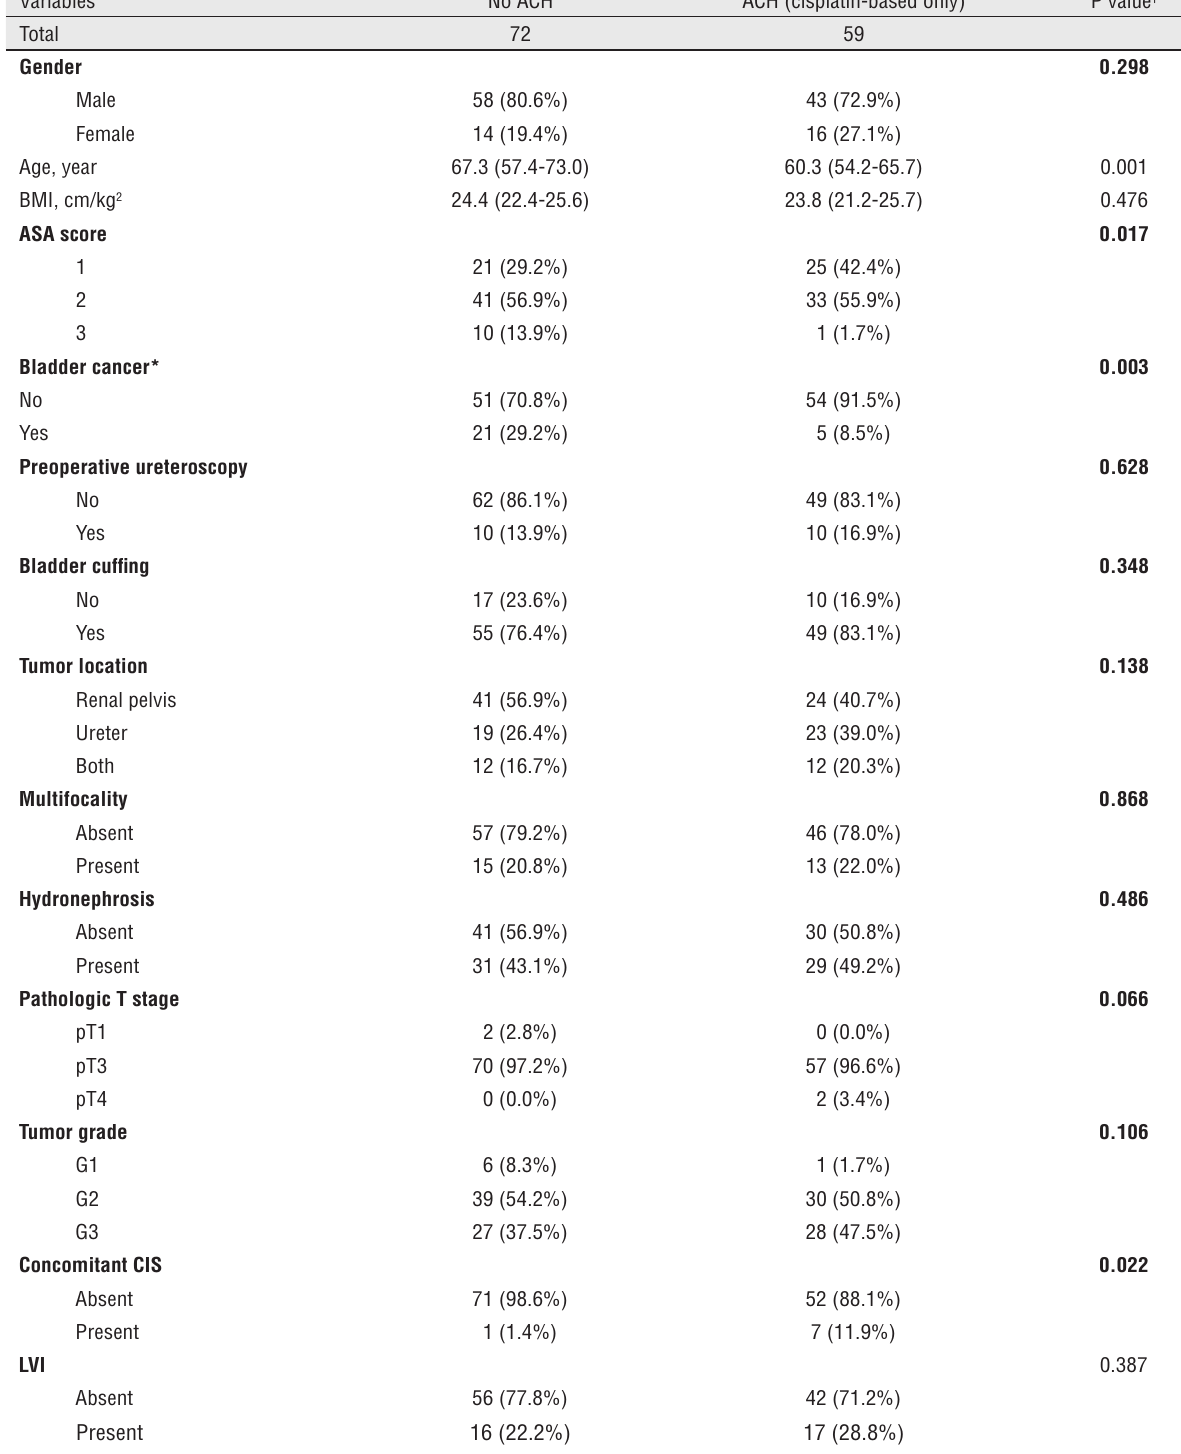
supplementary Table-1: patient